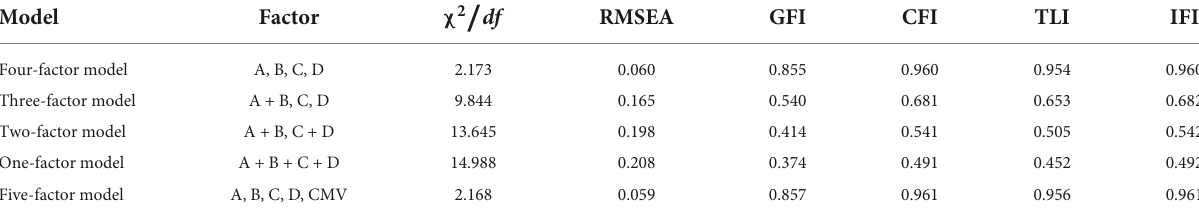
TABLE 1 Results of validated factor analysis of the discriminant validity of variables ( N = 324).